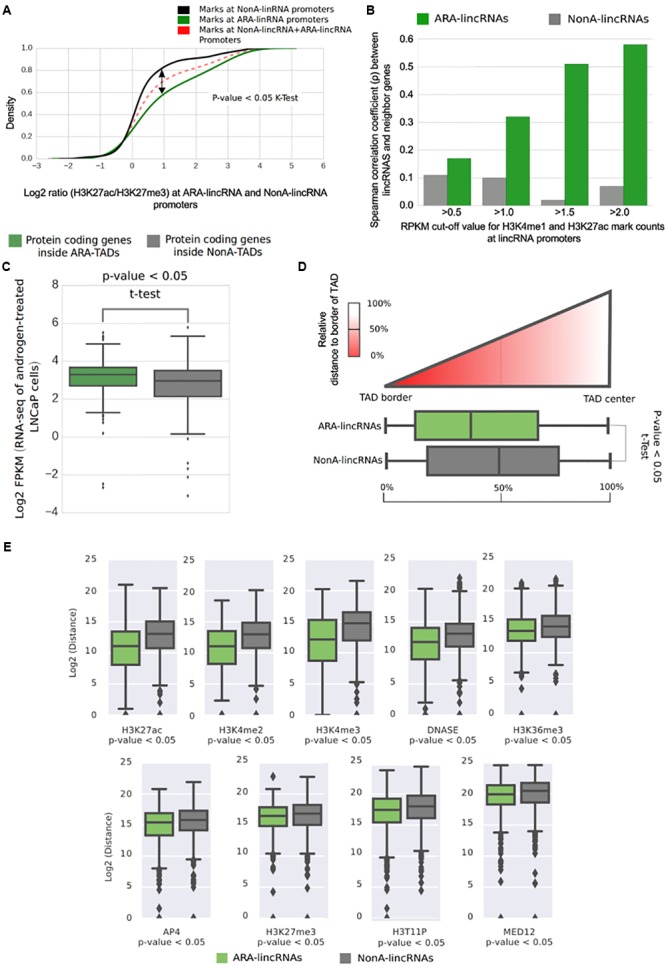
Transcription start sites of ARA-lincRNAs have an active enhancer epigenetic profile and ARA-lincRNA expression correlates with that of the protein-coding gene neighbor. (A) Cumulative distribution of the log2 ratio (H3K27ac/H3K27me3) of active enhancer marks mapped at the ARA-lincRNA promoters(green) and at the NonA-lincRNA promoters (black). ARA-lincRNAs have a significantly higher (one-sided Kolmogorov–Smirnov K-test; p < 0.05) positive log2 ratio than NonA-lincRNAs. (B) Correlation between androgen-induced expression activation of lincRNAs and of neighbor protein-coding genes. Correlation was computed for the set of ARA-lincRNAs (green) and for the control set of NonA-lincRNAs (gray). Different, more restricted sets of lincRNA/protein-coding gene pairs were used, with increasingly more stringent cut-off values for the read-counts of enhancer marks H3K4me1 and H3K27ac at the TSS of the lincRNAs (ranging from >0.5 to >2.0), as indicated on the x-axis. (C) Box plot of the log2 FPKM in LNCaP cells for all protein-coding genes whose genomic coordinates are inside TADs that contain ARA-lincRNAs (green) and for all protein-coding genes inside TADs that contain NonA-lincRNAs (gray). The mean FPKMs are significantly different (one-sided t-test < 0.05) between the two groups, showing that protein-coding genes inside ARA-lincRNA-containing TADs are on average more highly expressed than those in TADs not containing ARA-lincRNAs. (D) The x-axis shows the distribution of TSS genomic coordinates of ARA-lincRNAs (green) and of NonA-lincRNAs (gray) relative to the closest TAD border and TAD-center. The ARA-lincRNAs (green) exhibited a significantly (one-sided t-test < 0.05) higher proximity to TAD borders than NonA-lincRNAs (gray). (E) Box plot of log2 (distance) in bp along the genome between the genomic locations of the indicated epigenetic mark and of the nearest TSS for either the ARA-lincRNAs (green) or the NonA-lincRNAs (gray) expressed in LNCaP cells. The average distances were significantly different (p < 0.05, t-test) between the two groups of lincRNAs, for each epigenetic mark shown here.